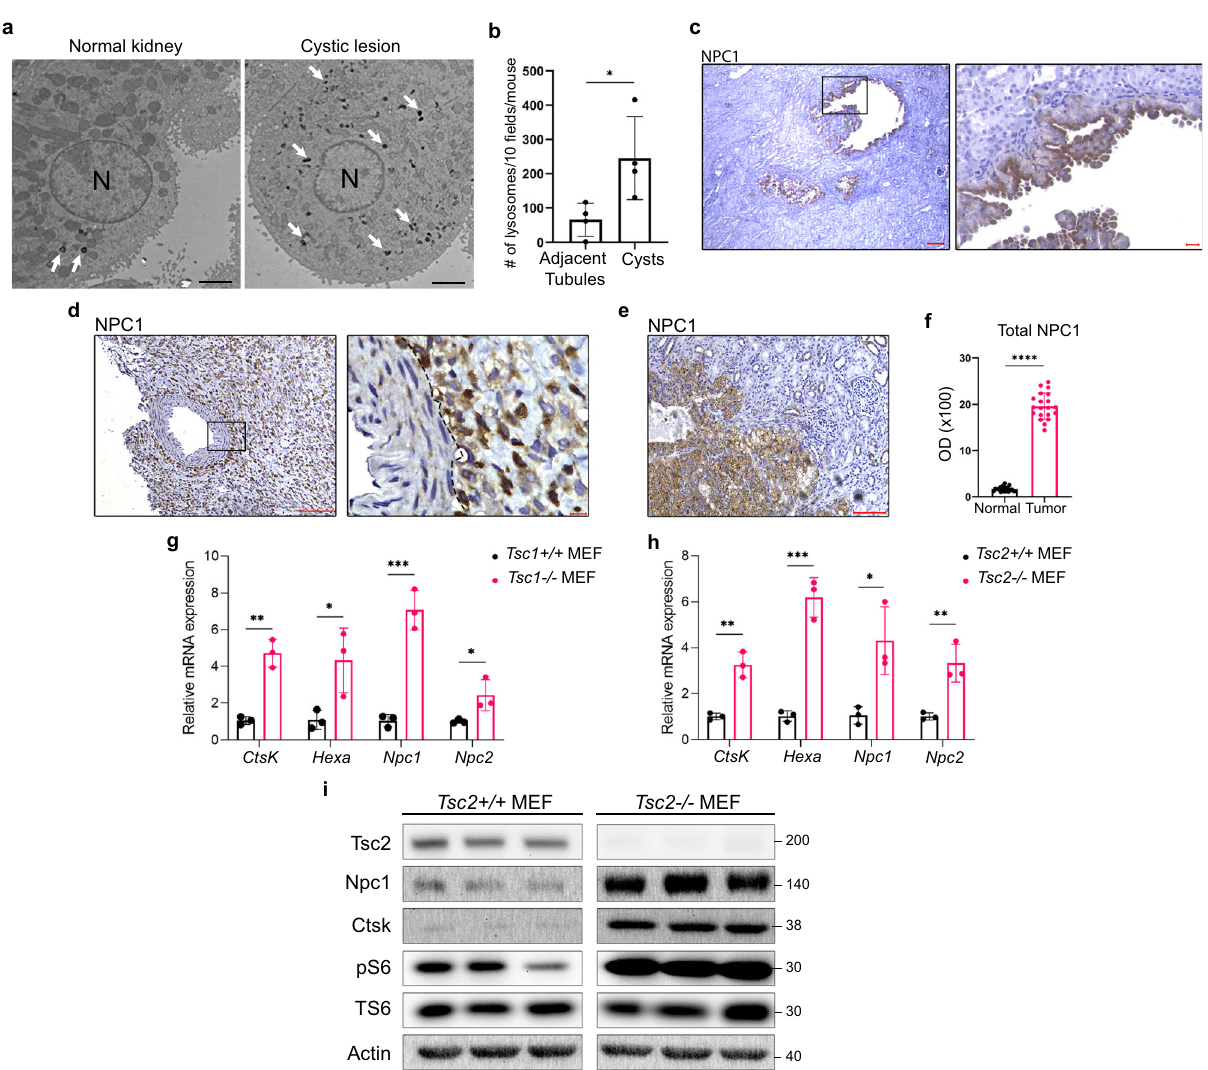
Fig. 1 Increased lysosome biogenesis in TSC. a Transmission electron microscopy representative images showing increased lysosomes (white arrows) in renal cyst-lining cells in 18mo Tsc2 + / − mice compared to the normal kidney. N denotes nucleus. Scale bar = 2 µ m. b Quanti fi cation of lysosomes in 10 fi elds/kidney in 18mo Tsc2 + / − mice cysts and adjacent normal tubules ( n = 4 kidneys), p = 0.0285. c – e Immunohistochemistry for the